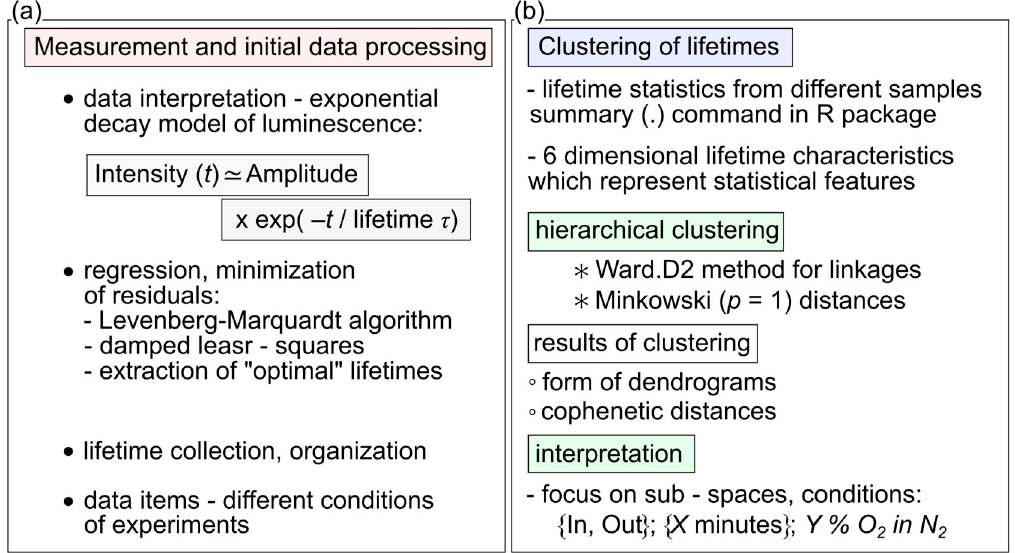
Figure 13. Schematic diagrams of ( a ) measurement and initial data processing, and ( b ) clustering of